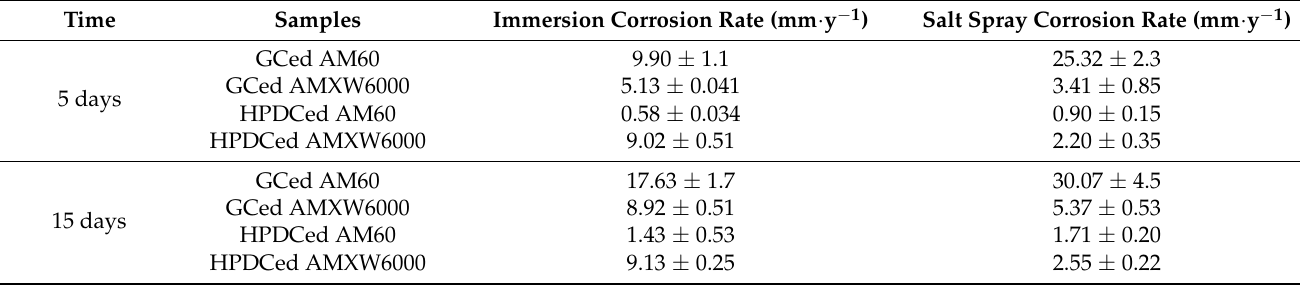
Figure 9. Corrosion rate examined by weight loss tests of GC and HPDC samples: ( a ) IT and ( b ) SST results, respectively.